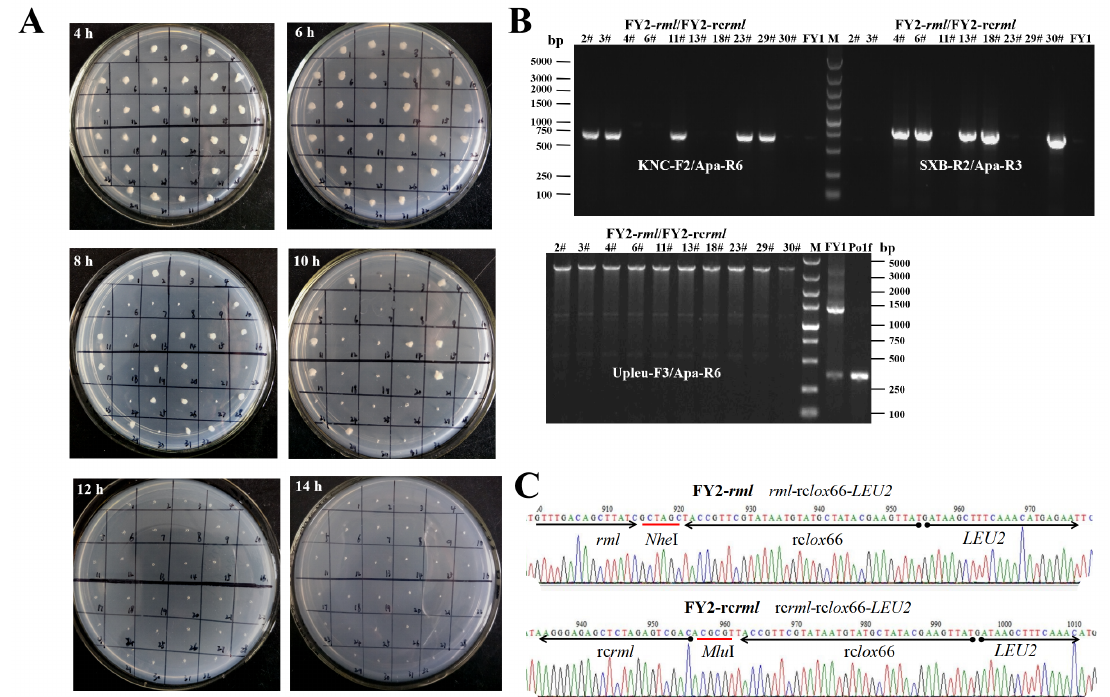
Figure 3. ( A ) Positive colonies induced for 4–14 h in the second-round integration. The corresponding BMSY plates are not shown. ( B ) PCR amplification to identify positive colonies in the second-round integration. Lane M, Marker. The fragment partial rml -rc lox 66-partial LEU2 (about 650 bp) was amplified with the primer pair KNC-F2/Apa-R6 only in FY2- rml strains. The segment partial rc rml -rc lox 66-partial LEU2 (about 800 bp) was cloned by SXB-R2/Apa-R3 only in FY2-rc rml strains. Different PCR products were obtained in four types of strains via amplification with Upleu-F3/Apa-R6: Upleu- lox 72- rml/ rc rml -rc lox 66-partial LEU2 (about 3500 bp) in FY2- rml /FY2-rc rml , Upleu- lox 71-Upleu-partial LEU2 (about 1300 bp) in FY1, and Upleu-partial LEU2 (about 300 bp) in the FY1 and Po1f strains. ( C ) Partial sequencing result of the PCR products rml -rc lox 66- LEU2 from FY2- rml and rc rml -rc lox 66- LEU2 from FY2-rc rml